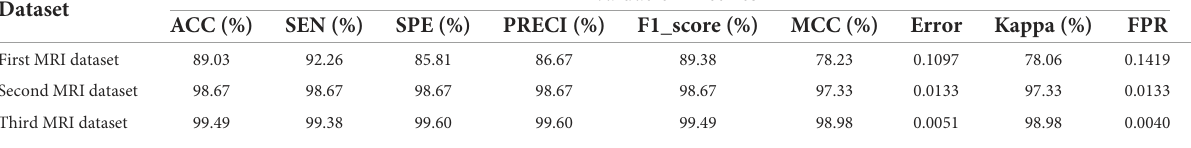
TABLE 4 Detection performance results for BRAIN-TUMOR-net based on stratified k -fold cross validation with a 75/25 training/testing ratio on the three